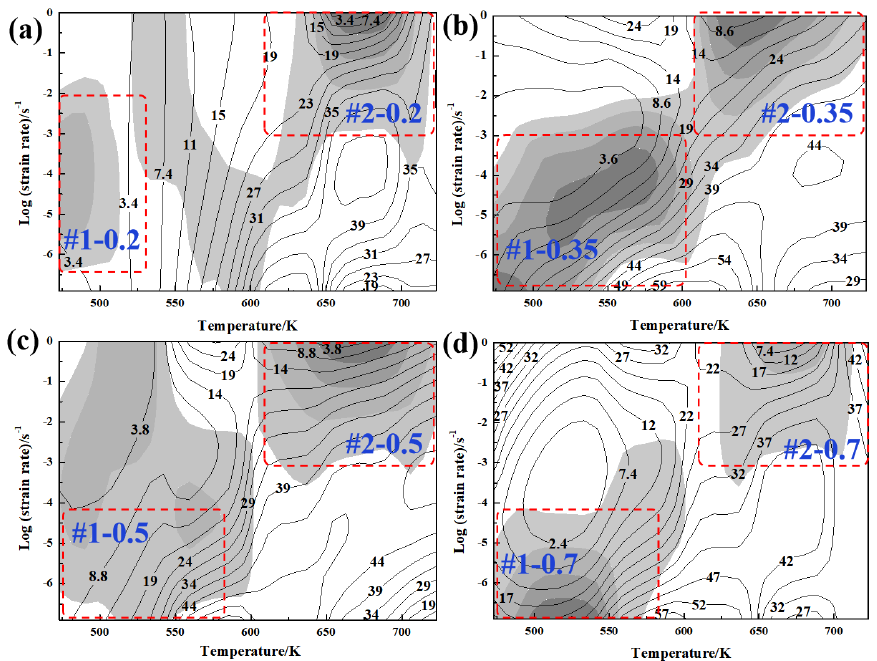
Figure 9. The processing maps of the Mg − 2Sn − 1Ca alloy under various strains. ( a ) 0.2 ( b ) 0.35 ( c ) 0.5 ( d ) 0.7.